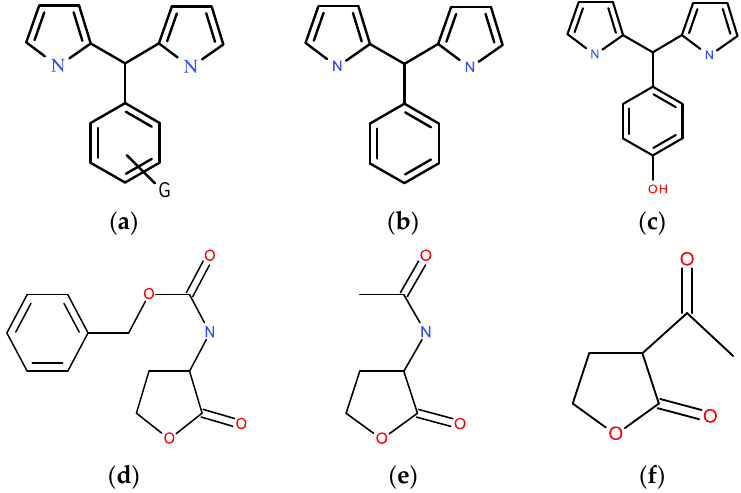
Figure 1. ( a ) General formula of 5-substituted dipyrromethanes; ( b ) 5-phenyl dipyrromethane; ( c ) 5-phenol dipyrromethane; ( d ) N-carbobenzoxy-L-homoserine Lactone (Cbz-HS) used as template; ( e ) acetyl-HS used as template; ( f ) α-acetyl-butyrolactone used as interferent.